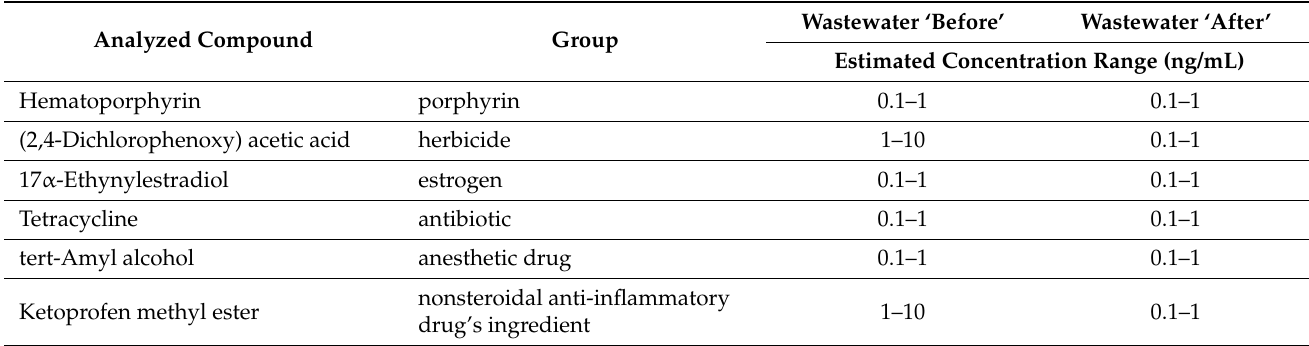
Table 3. Estimated concentration of various substances in wastewater ‘before’ and ‘after’ obtained from local wastewater treatment plant subjected to detailed analysis.